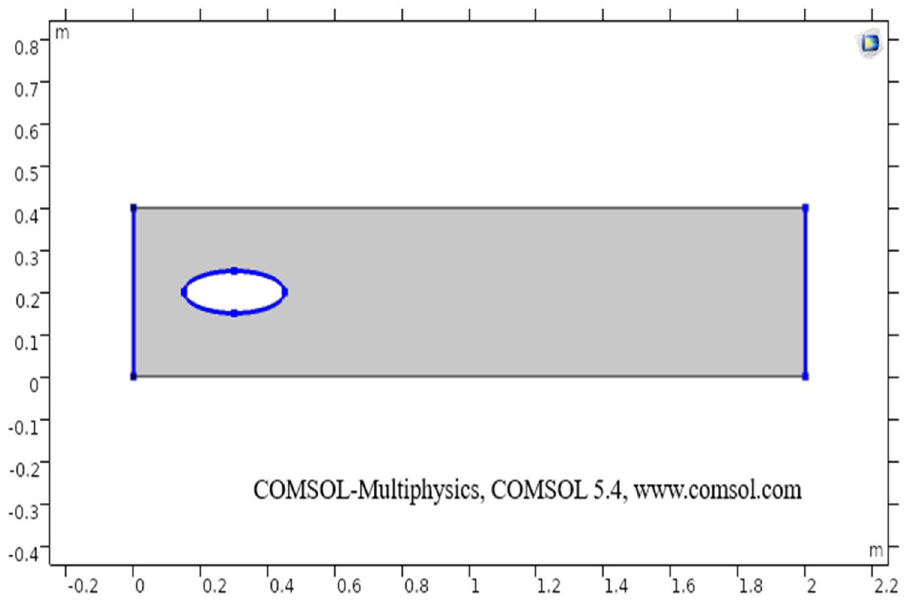
Figure 2. The thermally insulated boundary of flow geometry.